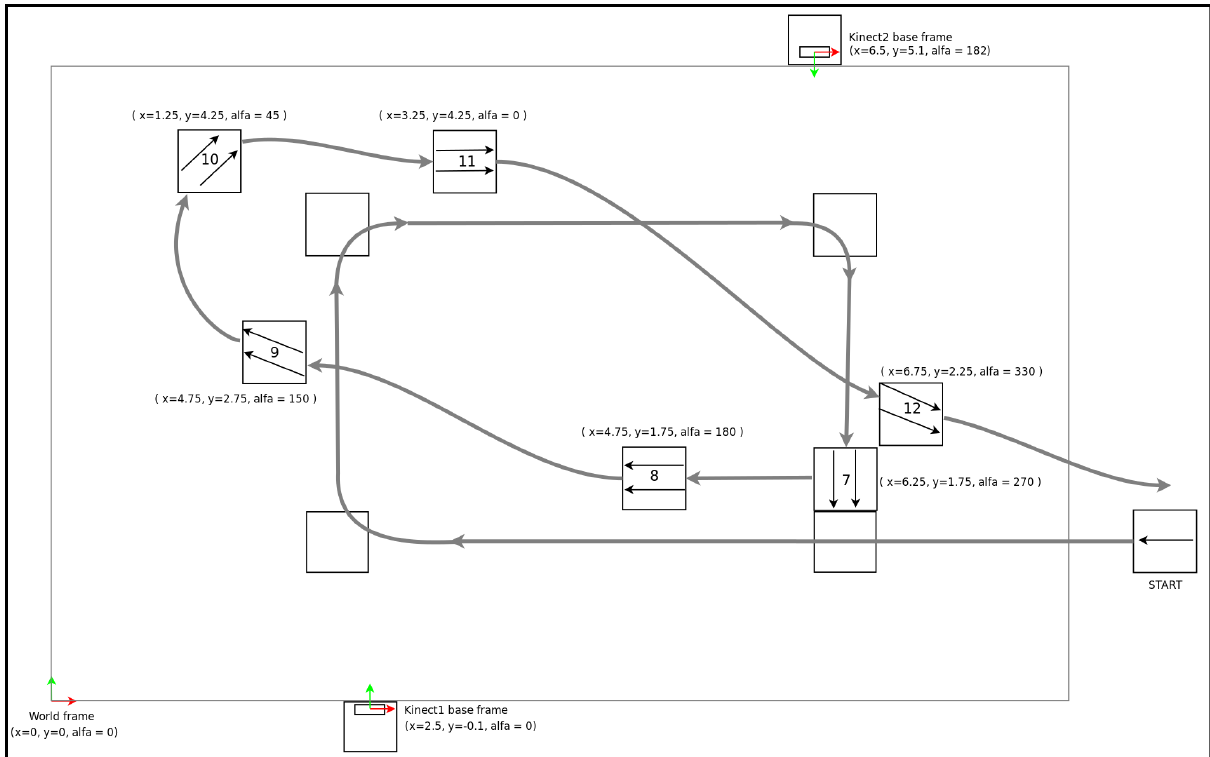
Figure 10. Schematic of marker positions and numbering for walks starting from the right